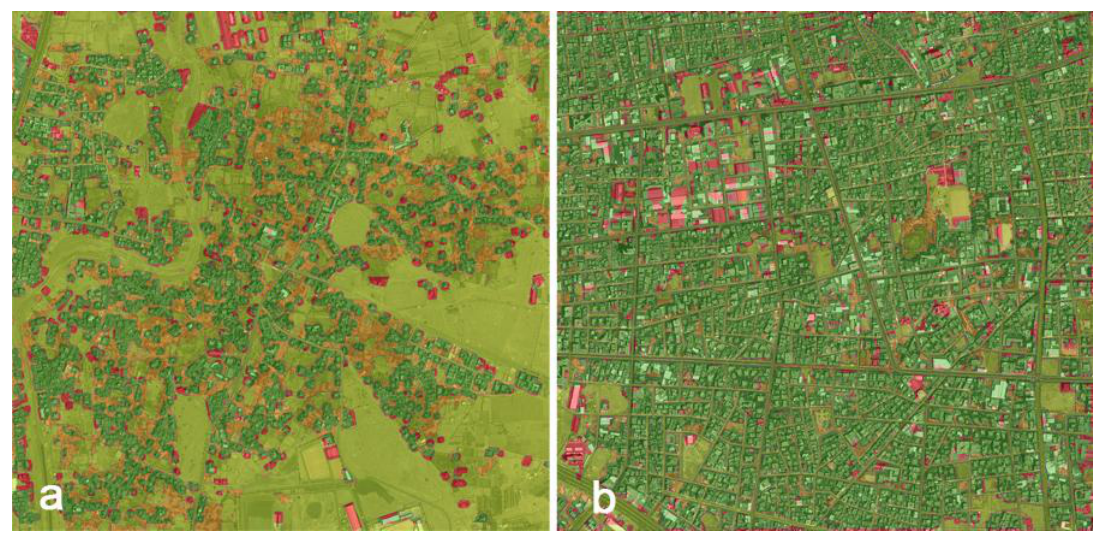
Figure 5. Suburban (a) and urban (b) subsets from Quickbird (2004) showing correctly classified built-up (BU) (dark green) and non-built-up (NBU) (light green) areas. Errors of omission are presented in (red) and errors of commission in